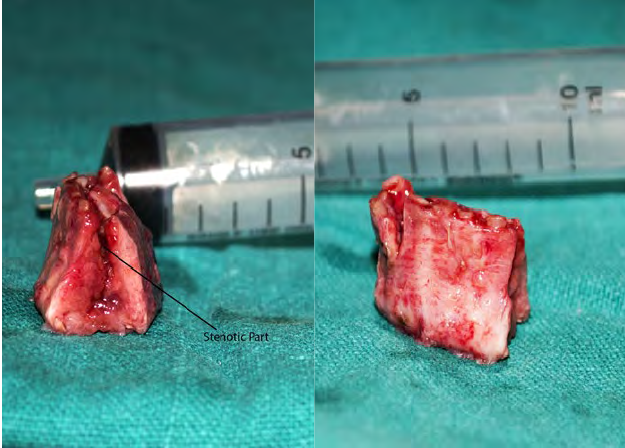
Fig 4 : Resected stenotic portion of trachea